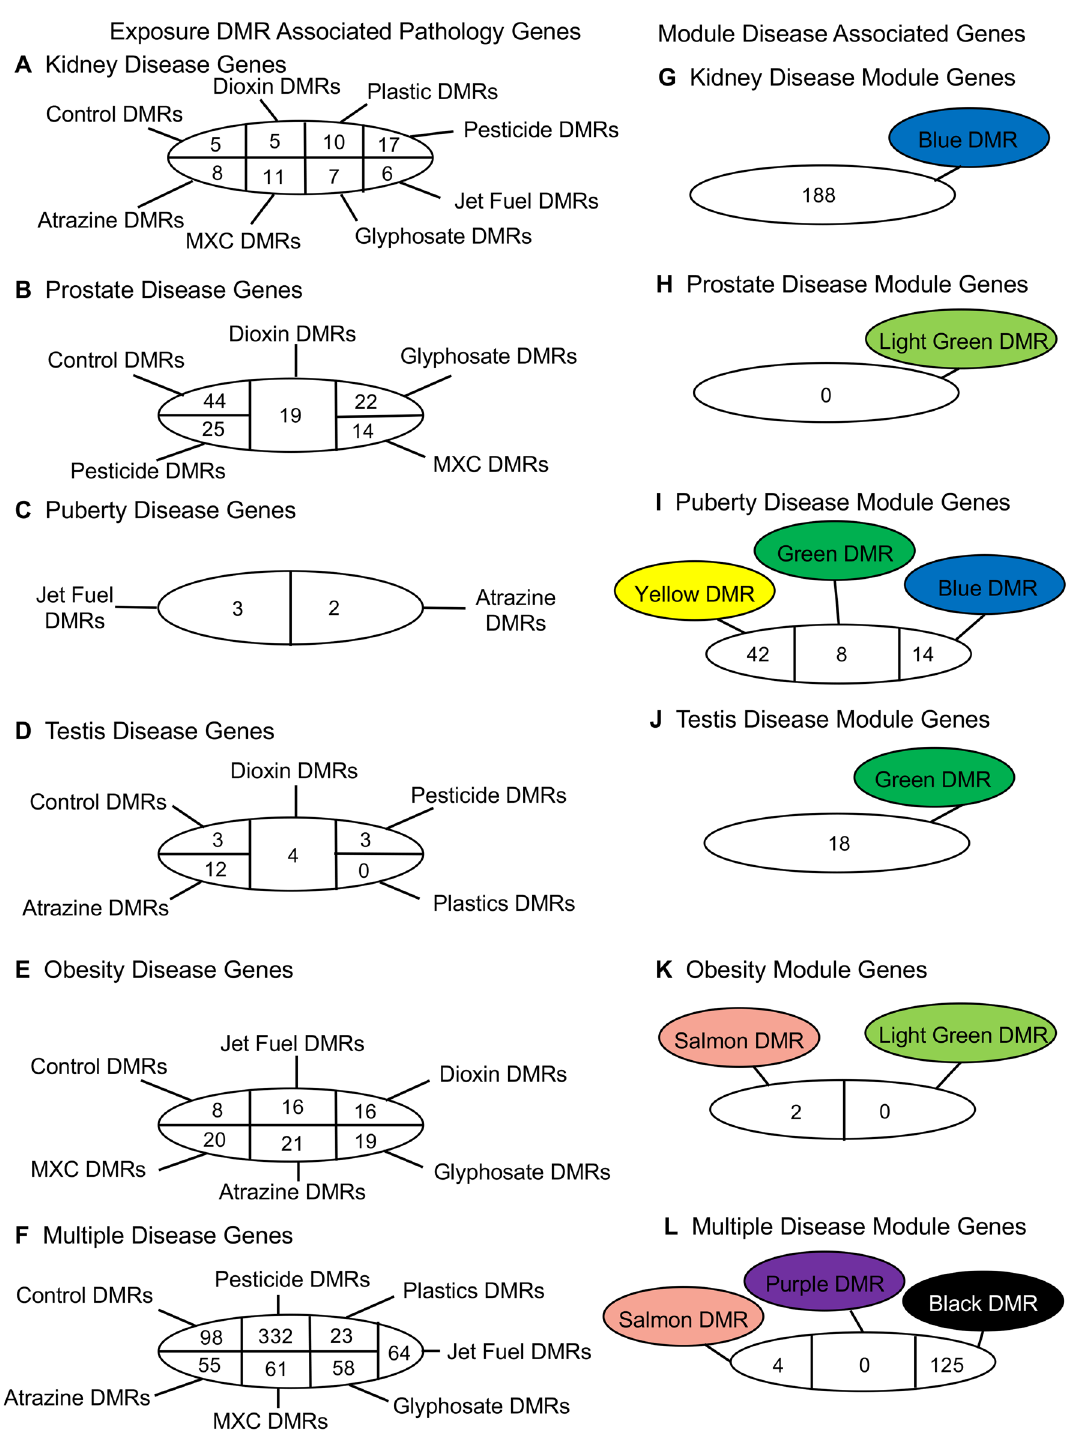
Figure 5. Exposure DMR associated pathology genes. Pathologies and specific number of DMR per exposure: ( A ) Kidney; ( B ) Prostate; ( C ) Puberty; ( D ) Testis; ( E ) Obesity; ( F ) Multiple. Module disease associated genes; ( G ) Kidney disease module associated genes; ( H ) Prostate disease module associated genes; ( I ) Puberty disease module associated genes; ( J ) Testis disease module associated genes; ( K ) Obesity disease module associated genes. ( L ) Multiple disease module associated